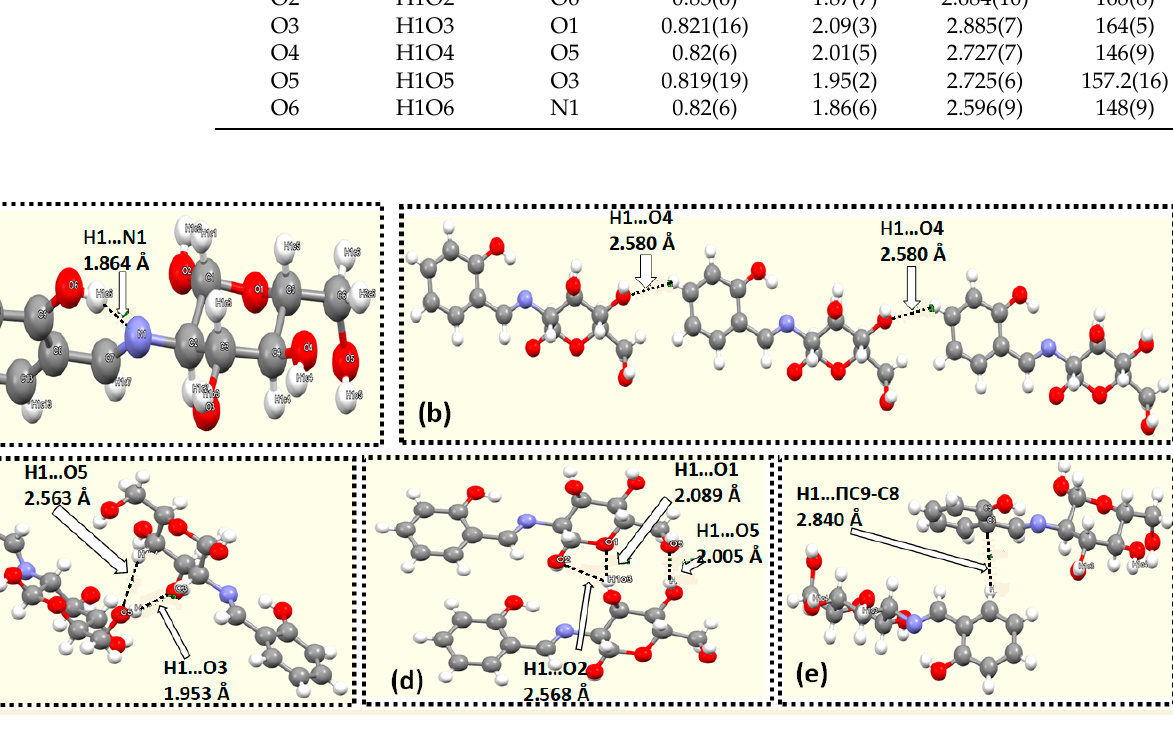
Figure 3. ( a ) OH…N intraH- bond, ( b ) Ph-H…O interH-bond, ( c ) 2D-S6-synthon, ( d ) 2D-S4 synthon, and ( e ) H… π C9-C8 Figure 3. ( a ) OH . . . N intraH-bond, ( b ) Ph-H . . . O interH-bond, ( c ) 2D-S6-synthon, ( d ) 2D-S4 synthon, and ( e ) H . . . interactions types in the GASB-1 lattice. π C9-C8 interactions types in the GASB-1